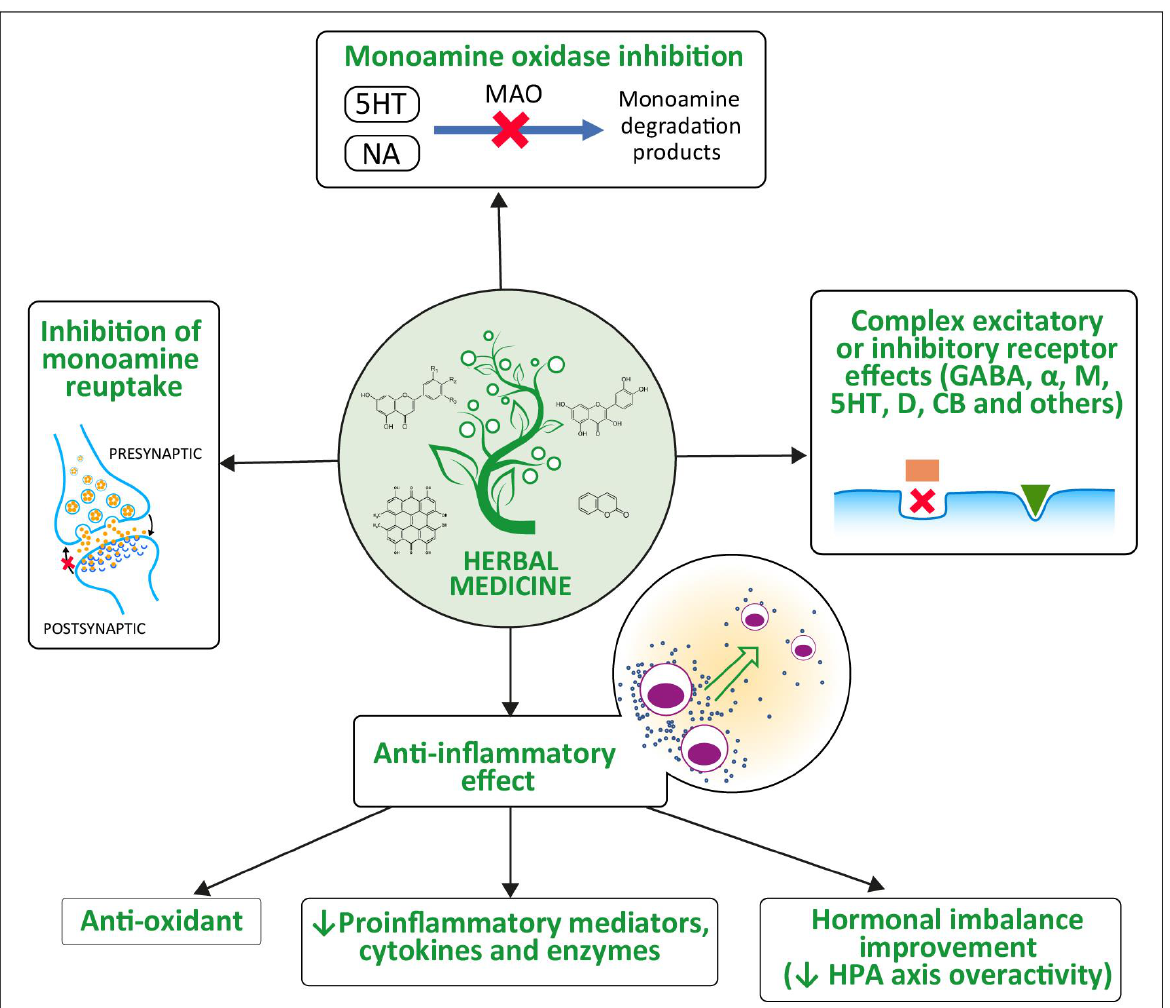
Figure 2. The summary of the elements of the mechanisms of action of plants with antidepressant activity. According to the theory of synergistic and polyvalent action of active ingredients contained in medicinal plants (symbolically marked in the figure with selected chemical formulas), the anti- depressant effect is the result of the action of numerous co-occurring active compounds. The phar- macodynamics of these compounds involve similar mechanisms to those attributed to synthetic an- tidepressants. However, unlike synthetic antidepressants, an important aspect of the antidepressant effect of herbal preparations is also their anti-inflammatory action. Details are given in the text. (HPA – hypothalamic-pituitary-adrenal axis; 5HT – 5-hydroxytryptamine; serotonin; NA – noradren- aline; GABA – gamma-aminobutyric acid; α– adrenergic; M – muscarinic; D – dopaminergic; CB – can- nabinoid).